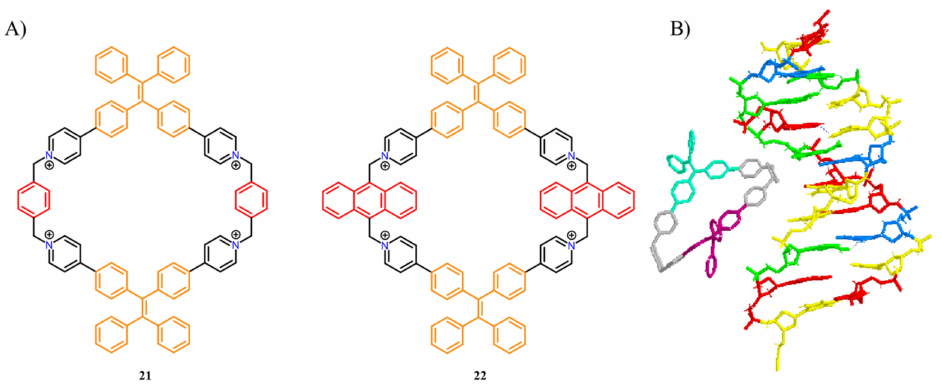
Figure 8. ( A ) The chemical structure of 21 and 22 . ( B ) The possible complex structure of 21 with DNA. TPE units have been introduced into an octa-cationic cage to give a meso-racemic compound because the two TPE cells in the cage adopt P and M helical conformations simultaneously [36]. Because of the existence of eight electron-defective pyridine rings, cage 22 was able to recognize electron-rich guest molecules well through C-H . . . π interaction and electrostatic interactions in water (Figure 9). The NMR studies indicated that 5 (cid:48) - adenosine monophosphate ( A ) enters the cavity of the cage completely, and its adenine unit locates in the center of the cage with the monophosphate group positions at the edge part of the cage. The host-guest complexation ratio was demonstrated to be 1:2. The deoxynucleotides cannot form stable base pairs in water due to interference from strong hydrogen bonds with water molecules, and the hydrophobic cavity of the cage is conducive to the formation of the hydrogen bond base-pair A 2 in 22 ⊃ A 2 complex. When deoxynucleotide was added to the aqueous solution of 22 , a strong CD signal appeared at 300–450 nm, suggesting that host-guest complexation favors the host conformation with a kinetically stable co-rotation. The negative CD signal in the 300–450 nm region indicated that the chiral guest promoted the conversion of 22 towards P , P conformation, while there were two stronger negative and positive CD signals at 200–250 nm and 250–300 nm, which were assigned to the n– π * and π – π * transitions of 22 and A , respectively. This result suggests that the chiral transfer and induction are due to the free conformational interconversion limitation and the improved population of the chiral conformation caused by the complexation between the cage and the guest. The guest molecules T and C also showed a similar chiral induction behavior. On the contrary, 5 (cid:48) -guanosine monophosphate ( G ) experienced chiral reversion upon increasing the concentration, exhibiting an obvious two-step complexation. Although part of the CD signal at the short wavelength reversed, the long wavelength kept a negative CD signal, revealing that 22 ⊃ G 2 complex is the P , P conformation. When complexed with A 2 , T 2 , C 2 , or G 2 , the cage exhibited the unique adaptive chirality of the P , P rotational conformation of the TPE units. Furthermore, based on the AIE properties of TPE, the complexed gels of 22 with deoxynucleotides showed strong CPL signals, which provide other opportunities for the manufacture of biocompatible CPL